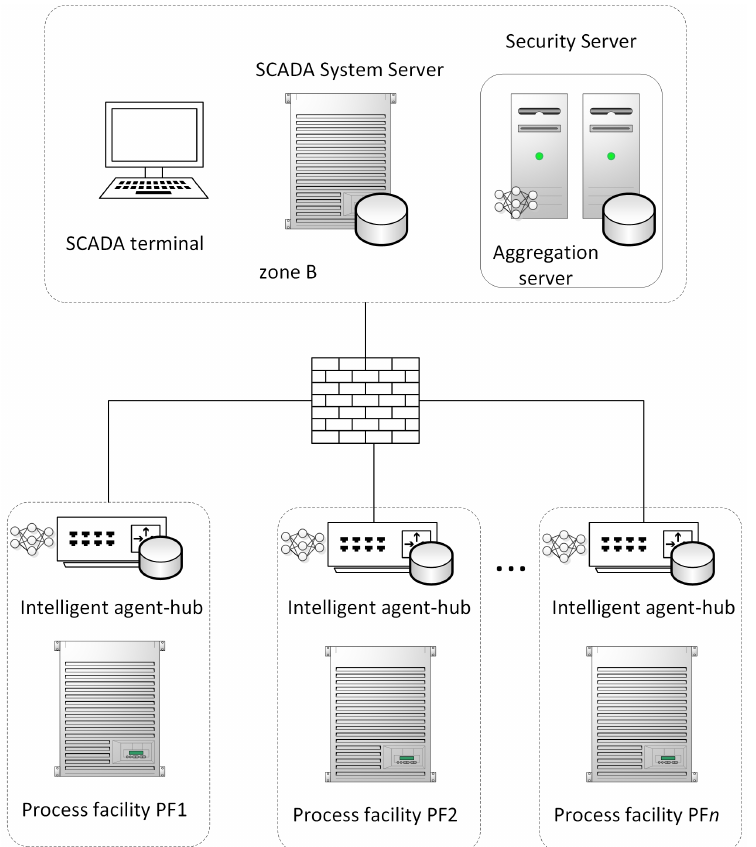
Figure 3. The intrusion detection system for the cyber-physical system with vertically partitioned